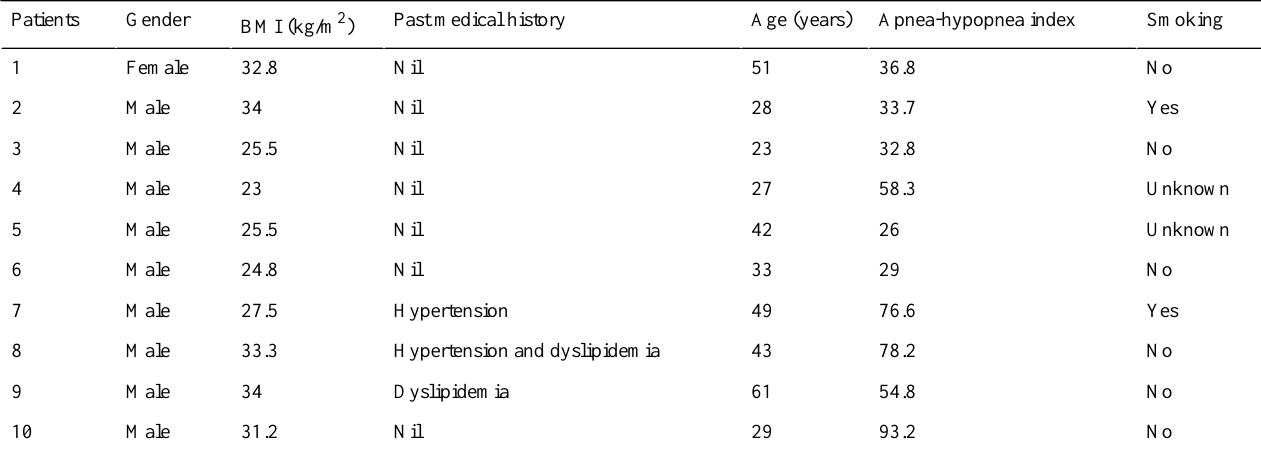
Table 1. Demographics and past medical history of recruited